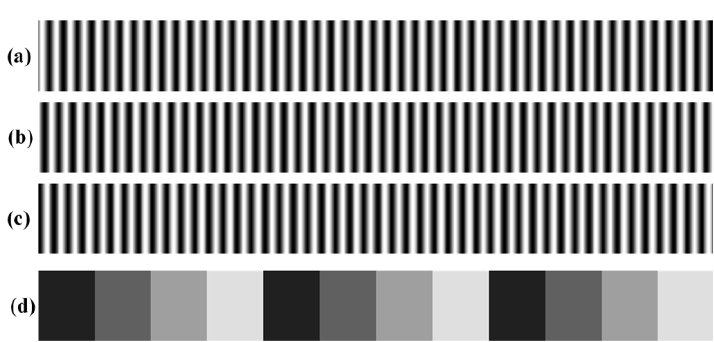
Figure 2. Projected patterns. ( a – c ) phase-shift patterns; ( d ) coded pattern.